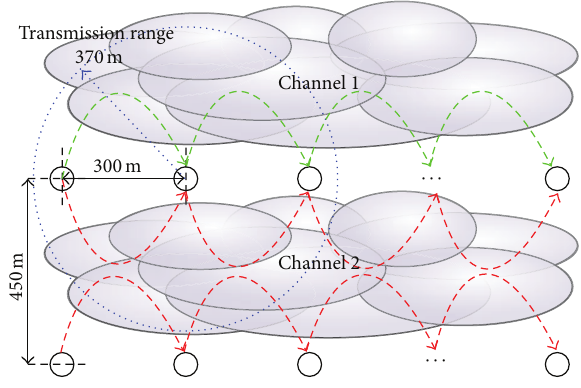
Figure 3: Simulation scenario from